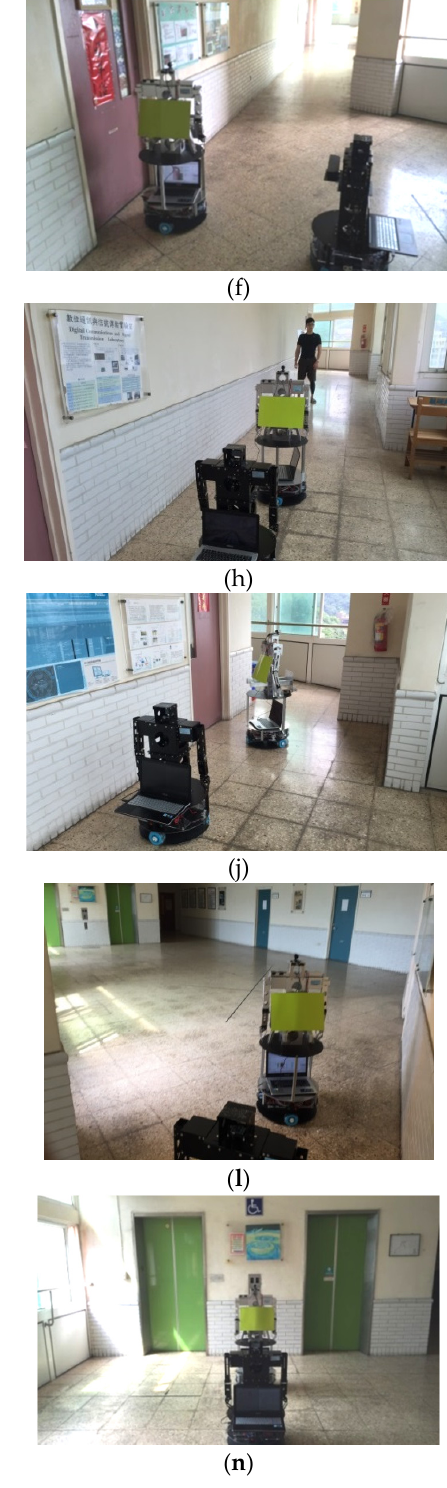
Figure 34. Experimental results of dual ‐ robot patrol. ( a ) Starting position; ( b ) detecting doors; ( c ) moving forward to destination door; ( d ) when the robot approaches to the door, it will correct its position to aim at the room plate and door; ( e ) if it is the correct destination, the robot will approach the door and use RFID to verify the tag UID; ( f ) the robot turns right after verification is confirmed; ( g ) shifting path; ( h ) find moving object; ( i ) mean shift tracking and send message to the control center; ( j ) come to the end and rotate; ( k ) shifting path; ( l ) find the starting point of the elevator; ( m ) go straight to the elevator; ( n ) arrive back at the starting position.